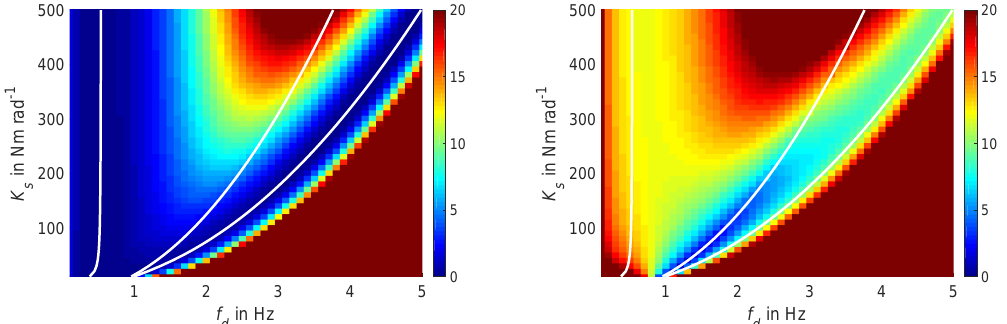
Figure 3. Consumed Energy per Oscillation in J considering electrical losses ( left ) and all losses ( right